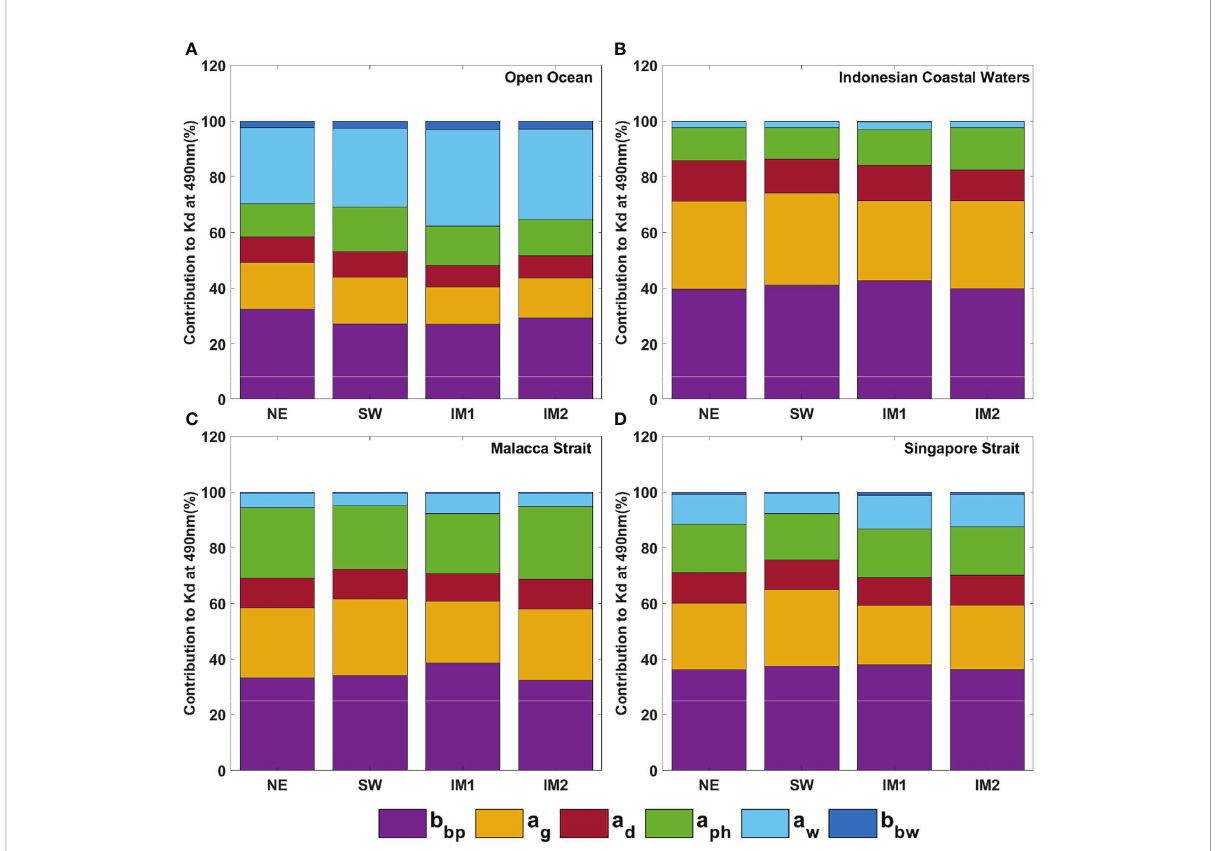
FIGURE 7 Relative contribution of bio-optical components to diffuse attenuation coef fi cient of light (K d ) at 490 for (A) Open Ocean waters, (B) Indonesian coastal waters, (C) Malacca Strait, and (D) Singapore Strait de fi ned in Figure 1. Relative contribution is computed seasonally for absorption